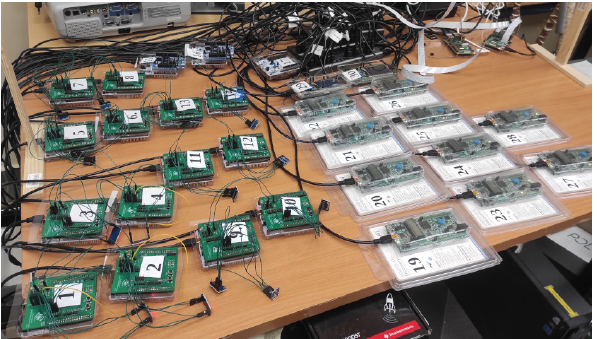
Figure 1. RemoteLab laboratory based on Raspberry Pi computers with cameras and STM32 Nu- cleo